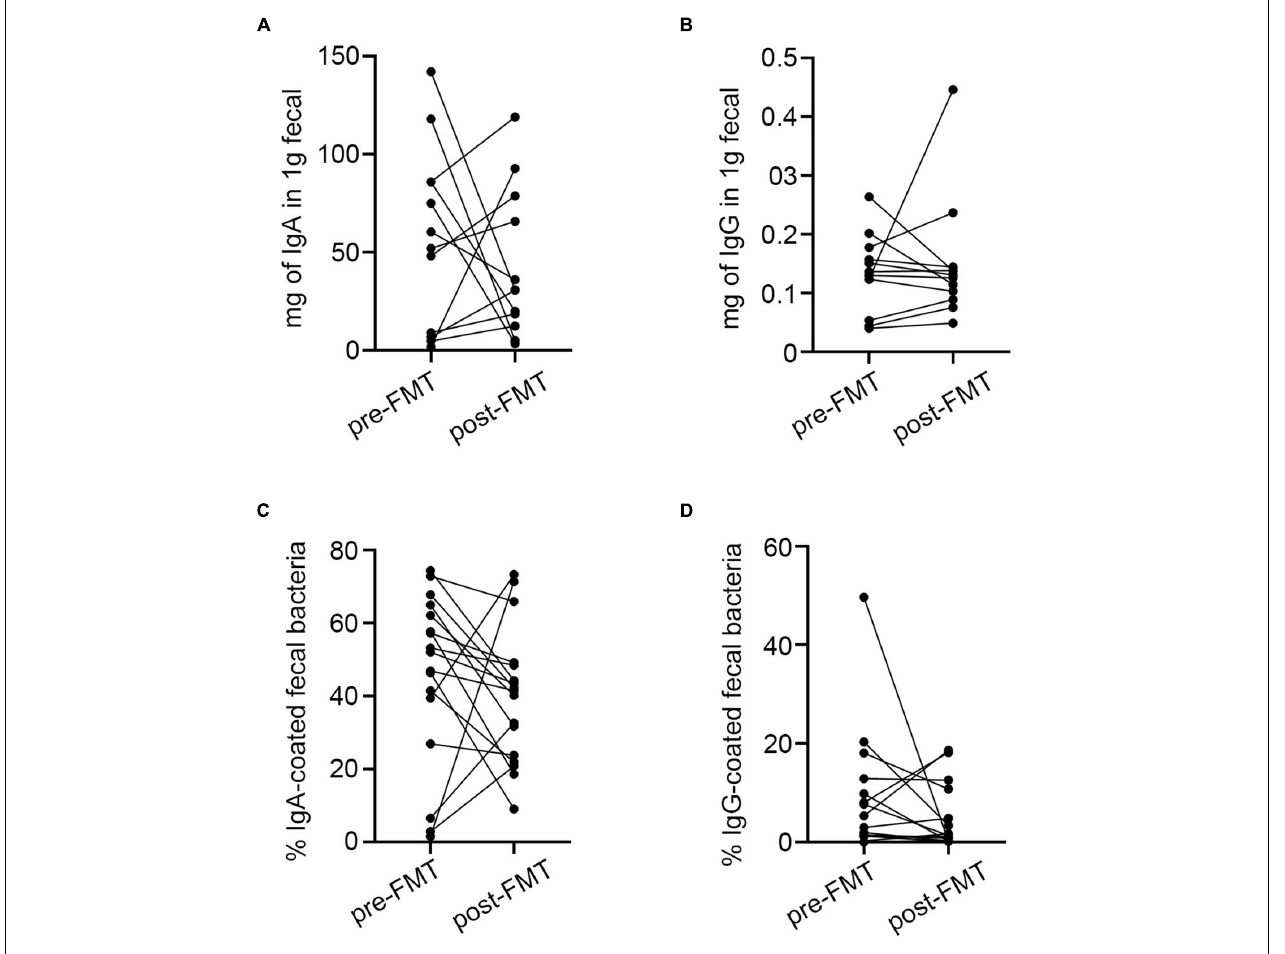
FIGURE 4 | Differences in IgA/G-bound microbiota and fecal free Ig before and after FMT. (A,B) Fecal-free Ig before and after FMT. (C,D) IgA/G-bound microbiota before and after FMT. * p < 0.05, **** p < 0.0001, ns means no significance